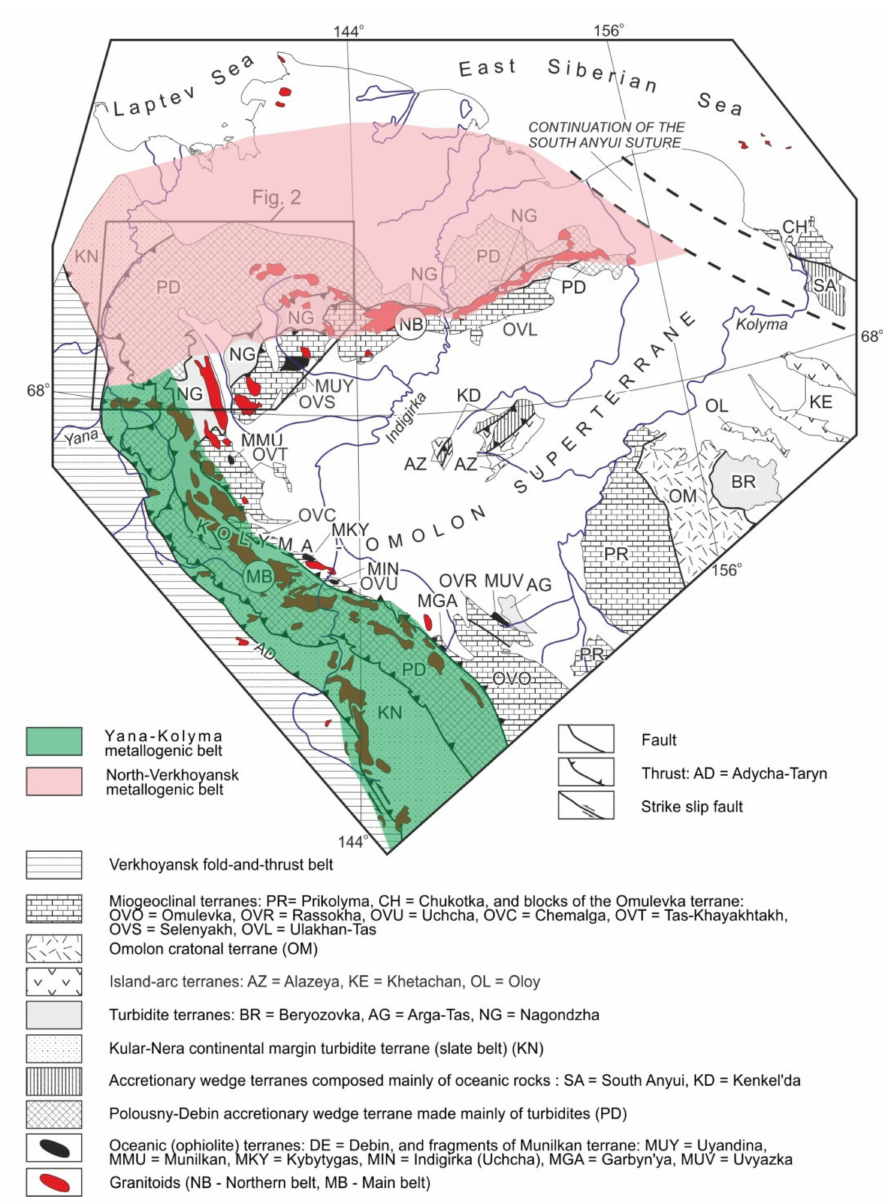
Figure 1. Tectonic map of the north-eastern Verkhoyansk–Kolyma orogenic belt, modified from